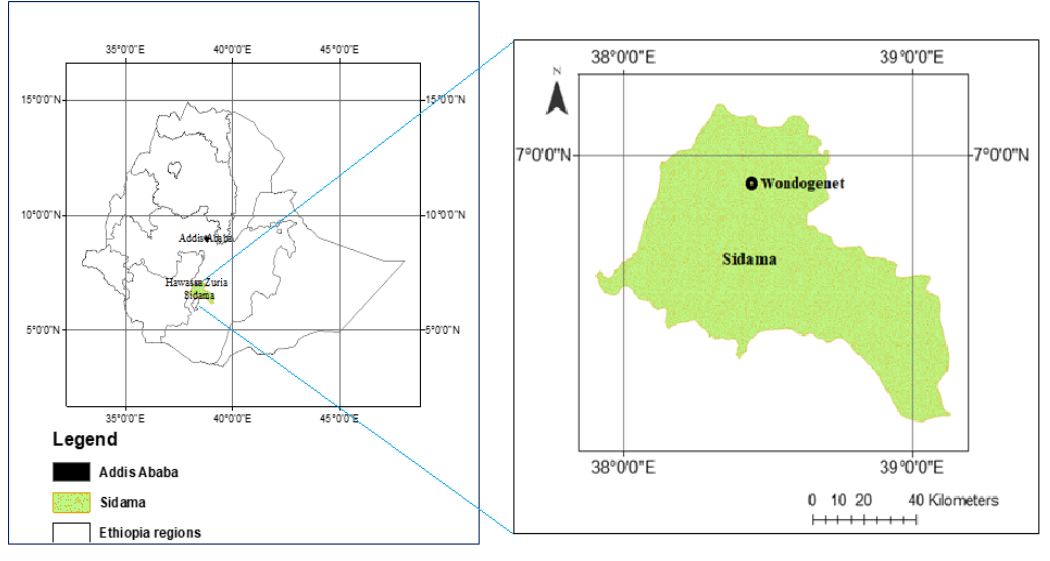
Figure 1. Maps showing the location of the study area, Wondo Genet, in the Sidama region of Ethiopia.